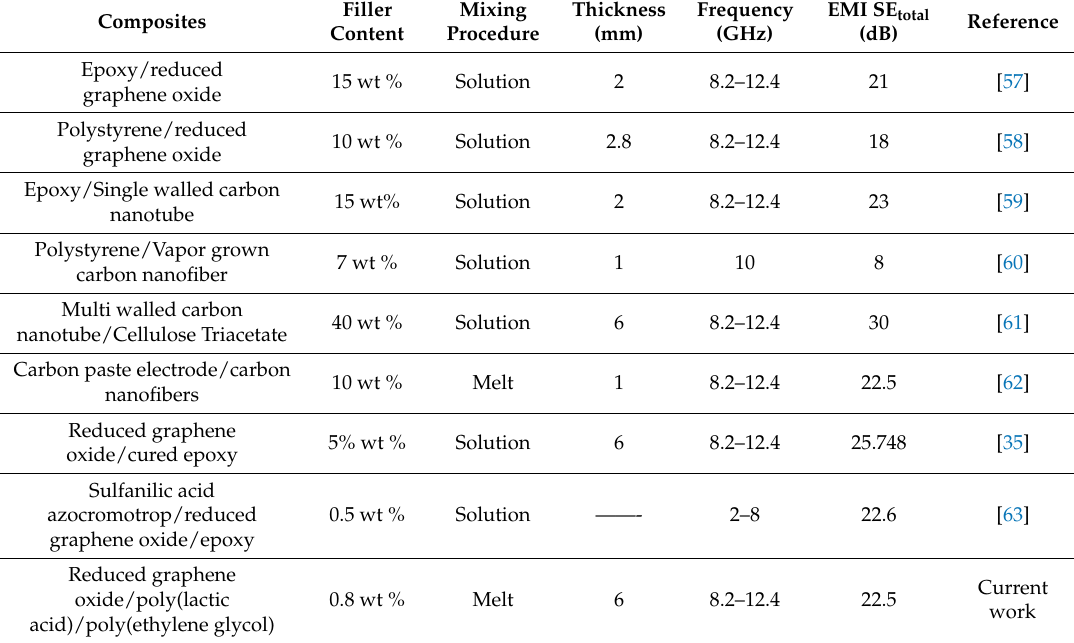
Table 4. Results of shielding effectiveness of commercial materials based on various polymer composites reported by previous authors in different